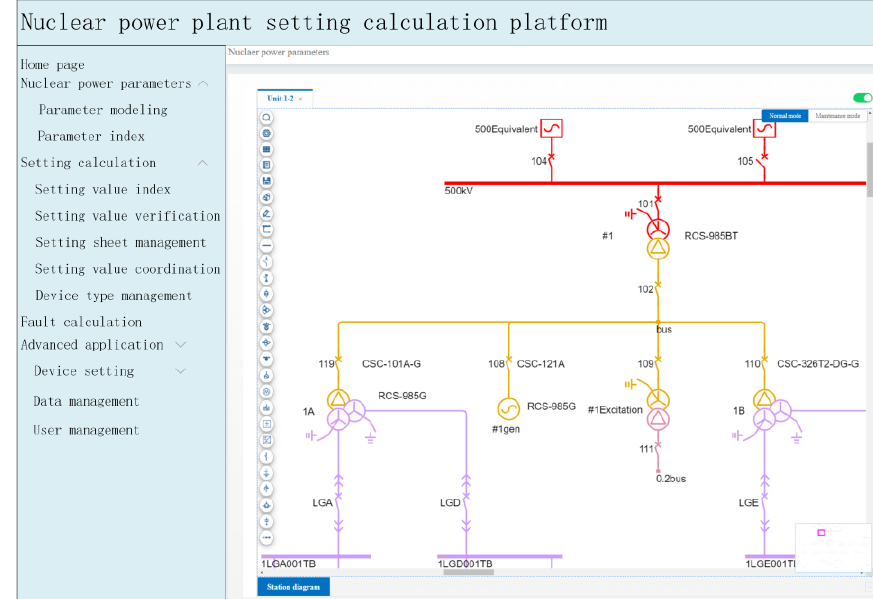
Figure 6. Nuclear power plant parameter modeling.